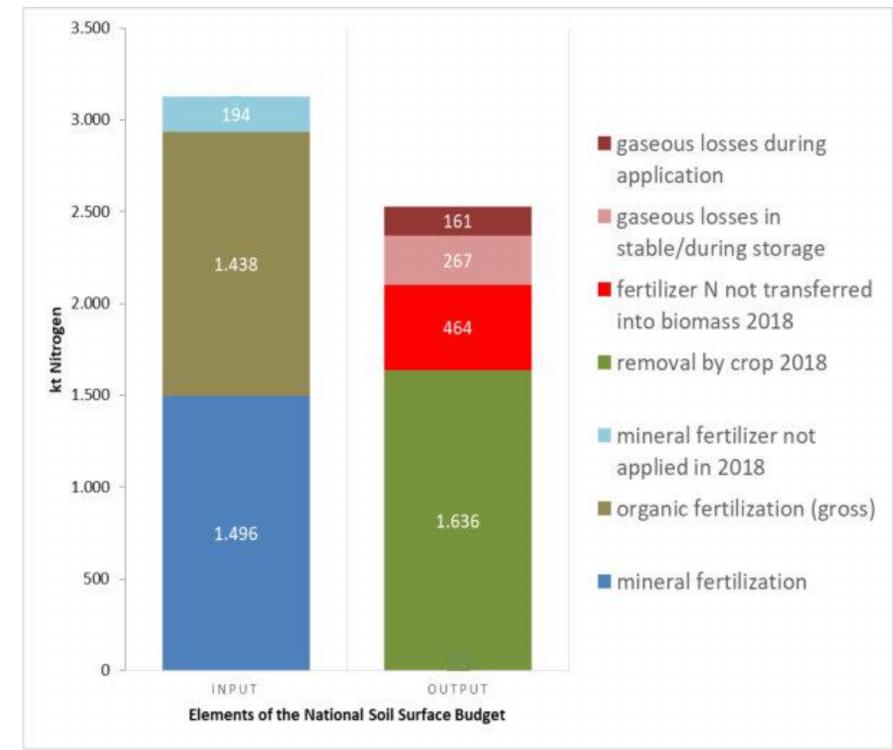
Figure 4. N-budget in 2018 (without N-deposition, legume N-fixation, and N-uptake by grazing animals in kt N / year): N-supply from organic fertilizers (left), N-removal by crop, gaseous losses in stable, storage and during fertilizer application, fertilizer not transferred into biomass (right) (source: own